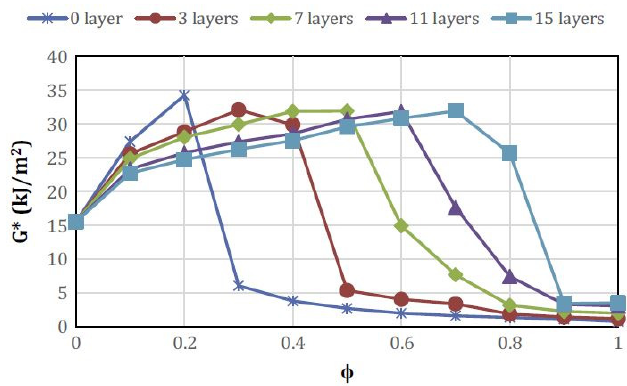
Figure 29. E ff ect of splitting density on the apparent fracture toughness of the z-Pinned laminate